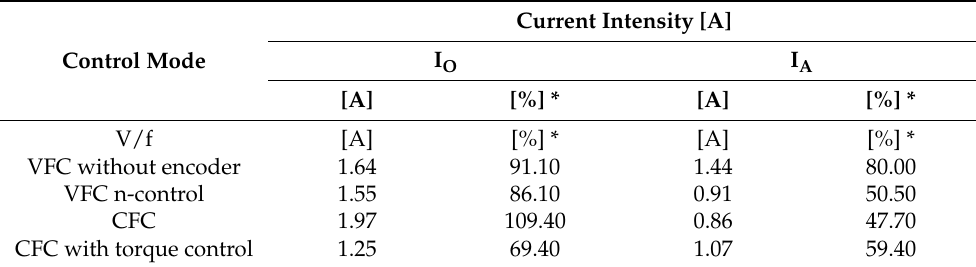
Table 12. Characteristics of the output current (I O ) and the active current (I A ) in a steady state (with the external load).